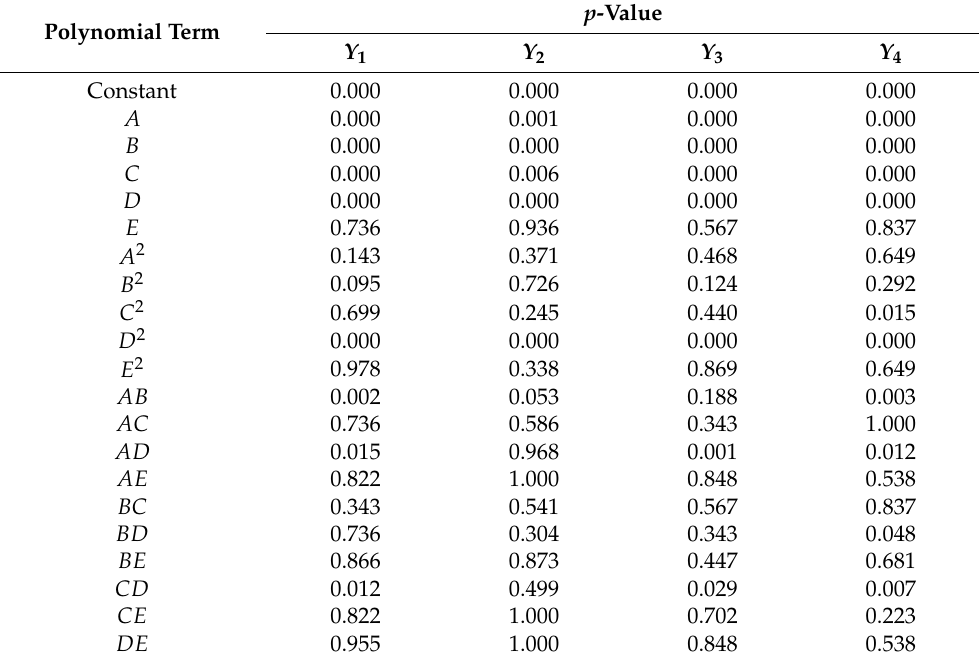
Table 8. The estimated regression coefficients for Y 1 , Y 2 , Y 3 , and Y 4